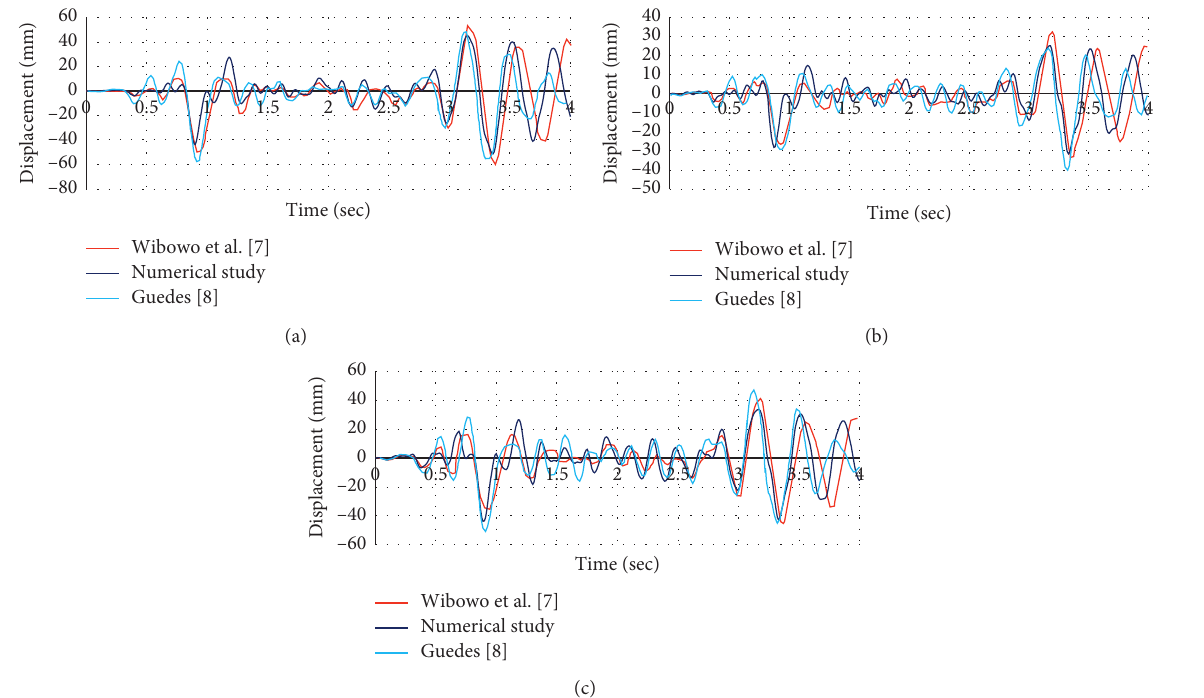
Figure 8: Comparison between the displacement time history of the top end of the piers of the numerical study and the research of Wibowo et al. [7] and Guedes [8] (linear box girder). (a) Short pier. (b) Medium pier. (c) Tall